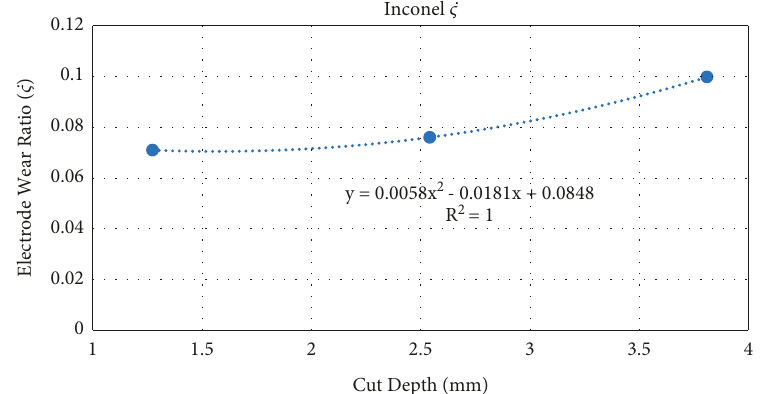
Figure 10: Mean _ ς due to cut depth in Inconel.